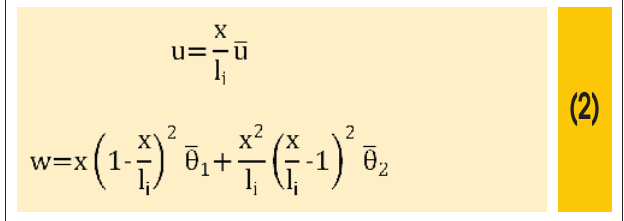
Figure 4 – Corotational reference system and kinematic variables (Battini